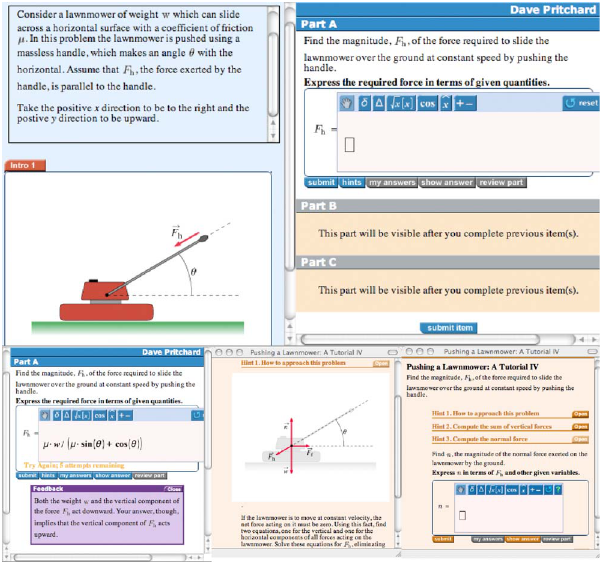
FIG. 1. (cid:1) Color (cid:2) Solving a “pushing a lawnmower” problem with MASTERINGPHYSICS (cid:1) top (cid:2) ; wrong answer feedback (cid:1) bottom left (cid:2) , de- clarative hint (cid:1) bottom middle (cid:2) , and procedural subtask (cid:1) bottom right (cid:2) .